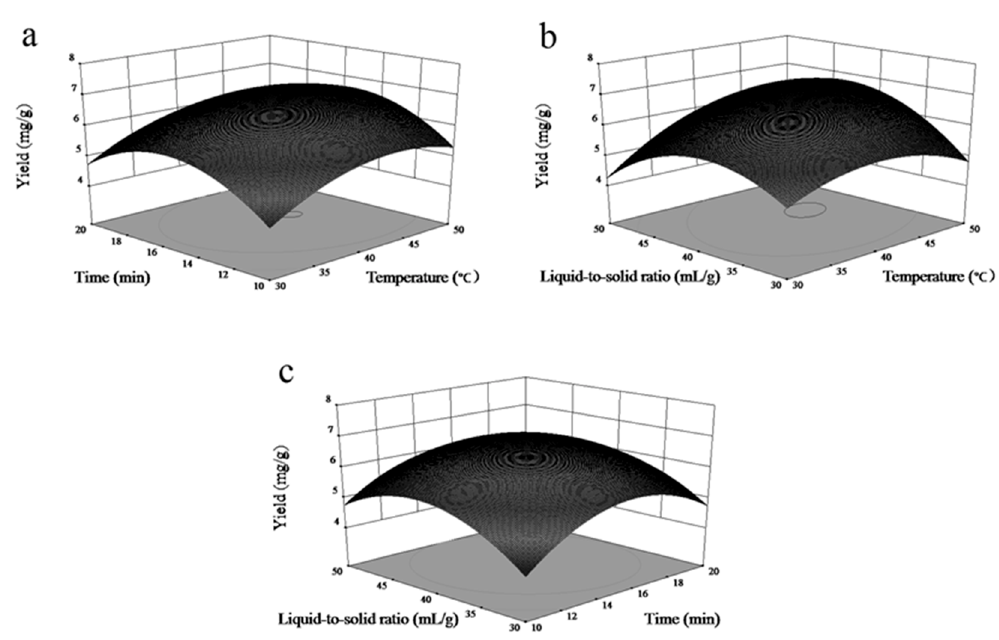
Figure 3. Response surface curves showing the effects of ( a ) time and temperature, ( b ) liquid-to-solid ratio and temperature, and ( c ) liquid-to-solid ratio and time on the extraction efficiency. Table 4. Estimated regression coe ffi cients of the fitted second-order polynomial equation.